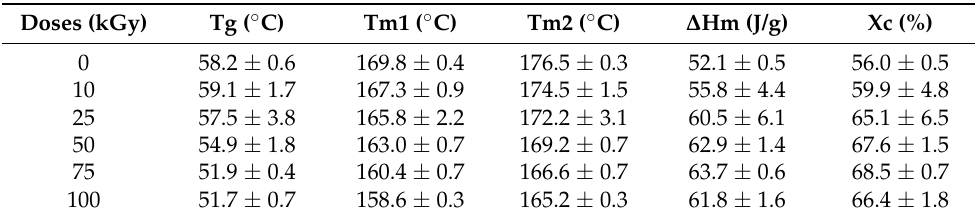
Table 1. Thermal properties obtained from DSC curves of PLA samples under EB radiation during the second heating.